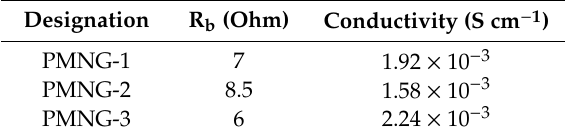
Table 2. DC conductivity for PVA:MC:NH 4 SCN:Gly systems at room temperature.